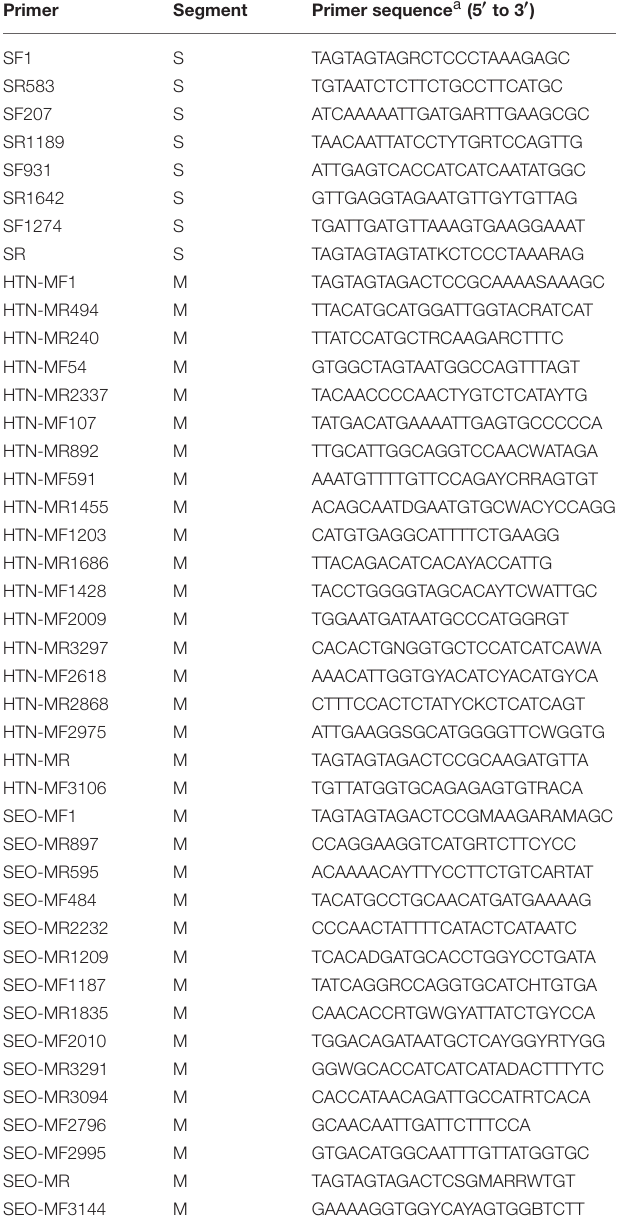
TABLE 1 | Primers used for nested and heminested PCR. Primer Segment Primer sequence a (5 ′ to 3 ′